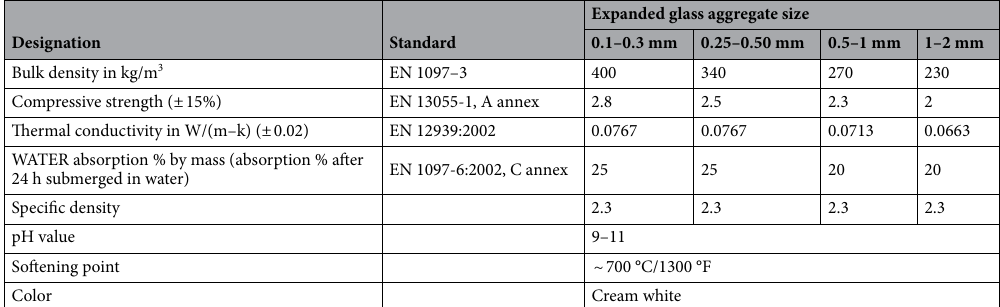
Table 2. Physical properties of expanded glass aggregates.